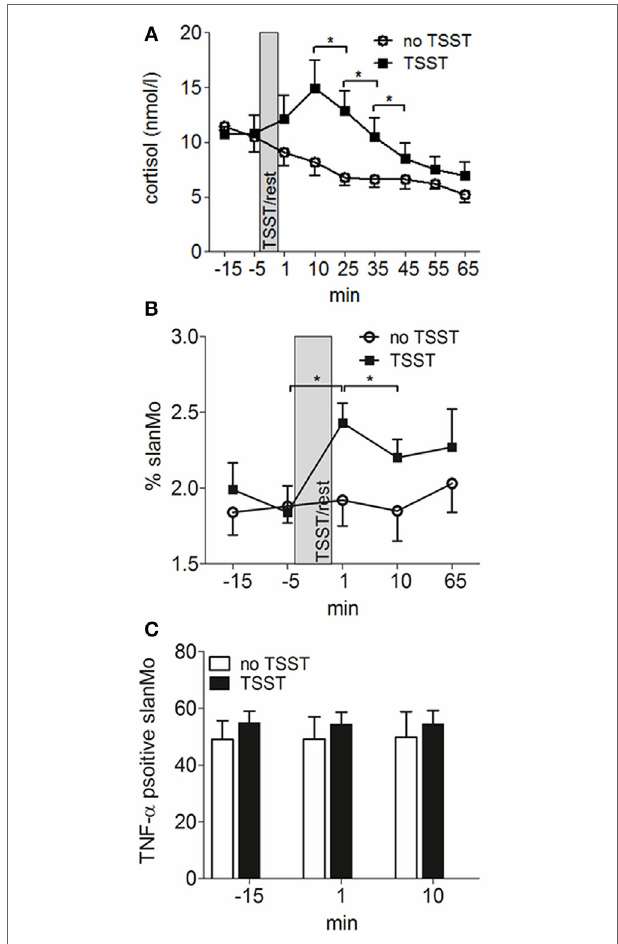
FigUre 5 | 6-Sulfo LacNAc-expressing monocytes (slanMo) are mobilized by mental stress and retain their capacity to produce TNF- α . (a) Blood cortisol levels were measured before and after induction of mental stress [Tier Social Stress Test (TSST)] in atopic dermatitis patients or after a resting period (no TSST) ( n = 12). Frequency of slanMo in peripheral blood mononuclear cells (B) and their TNF- α production (c) were determined by flow cytometry ( n = 7). Data are shown as mean + SEM and statistical significance was calculated using a one-way ANOVA followed by Tukey’s